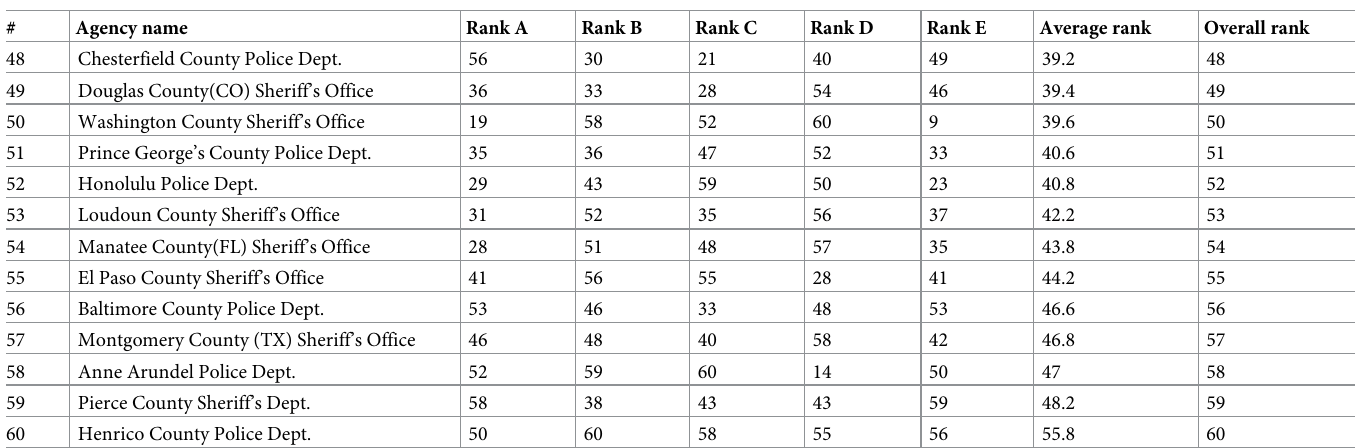
reacted to the George Floyd incident on social media and that the public paid attention to and seemingly held positive attitudes toward those changes. Police agencies in our sample tweeted more frequently following the killing of George Floyd and posted more tweets related to civil unrest as well as case updates. These tweets received greater public reaction (through favorites and retweets), which persisted throughout the study period.